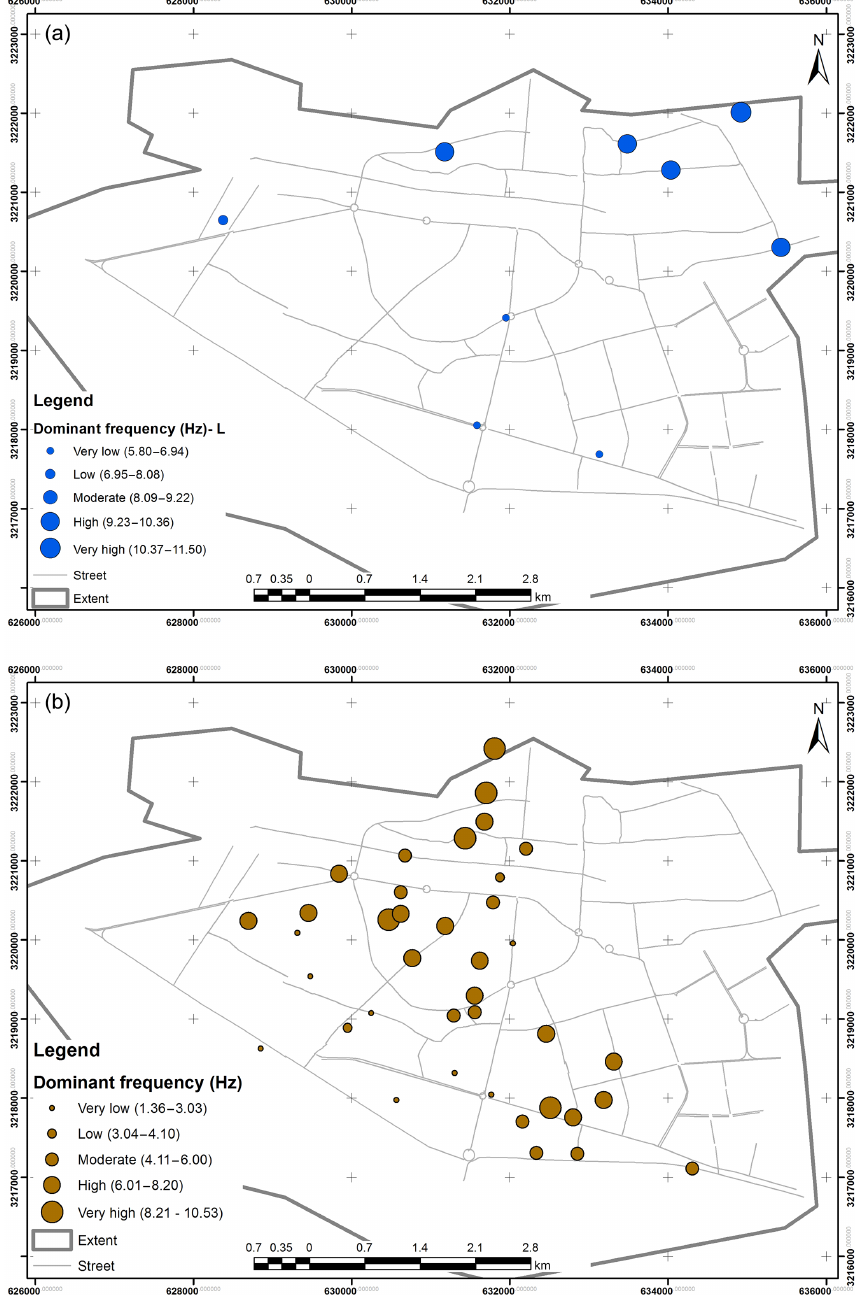
Figure 11. Control data: dominant frequency by LashkariPour et al. (2006) (a) and by Motamed et al. (2007) (b) using microtremor field